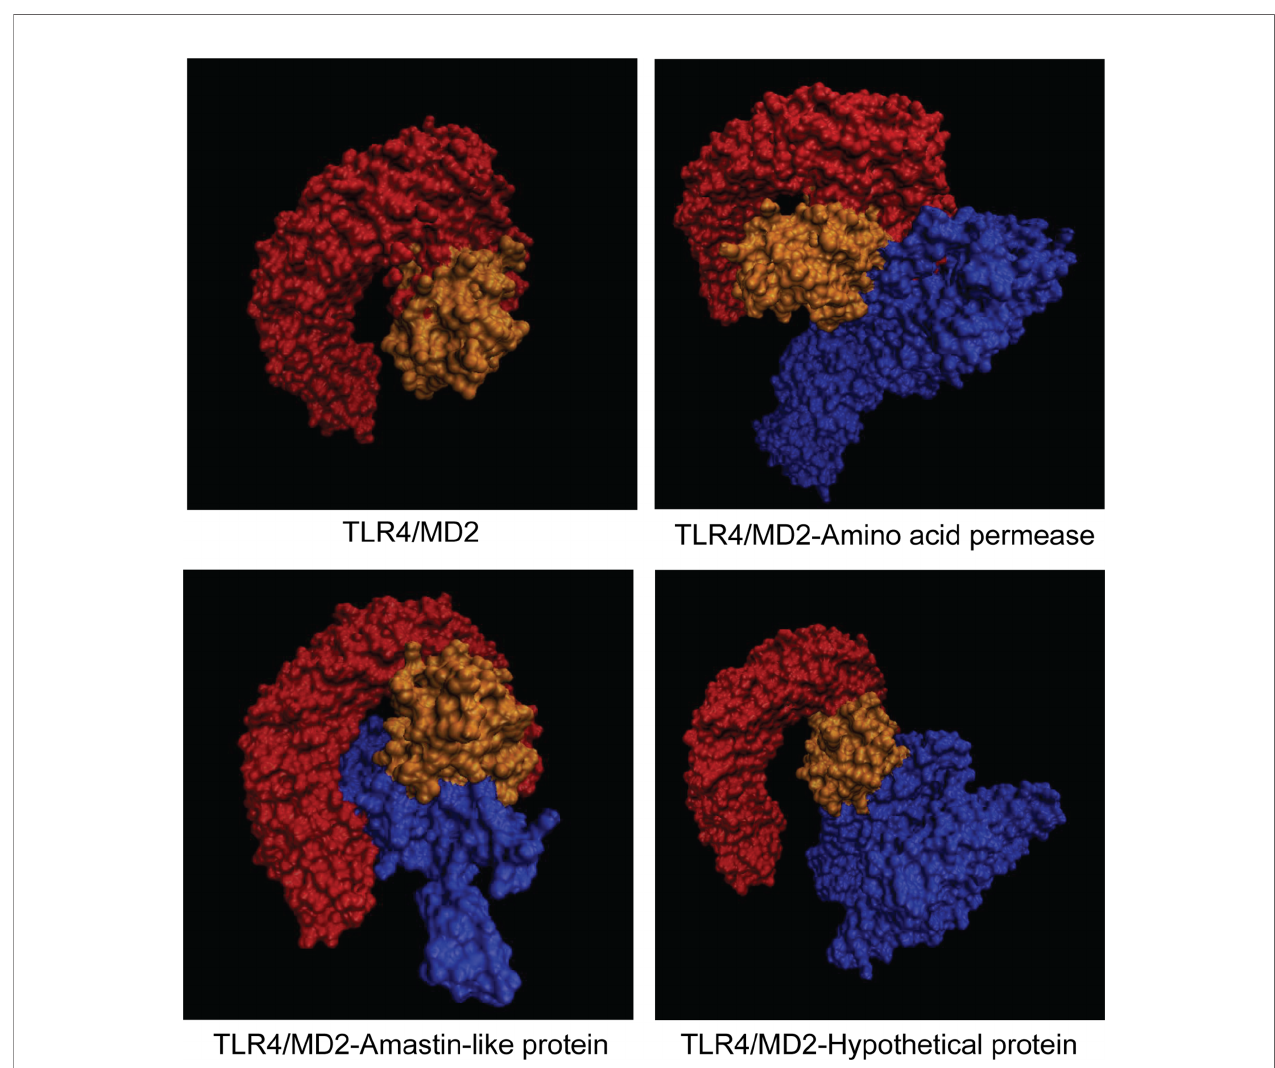
FIGURE 6 | Representation of docked complexes between TLR4/MD2 and vaccine candidates. TLR4 and MD2 were de fi ned as orange and yellow, respectively. Three vaccine candidates including amino acid protein, amastin-like protein, and the hypothetical protein (XP_003865405.1) were marked in